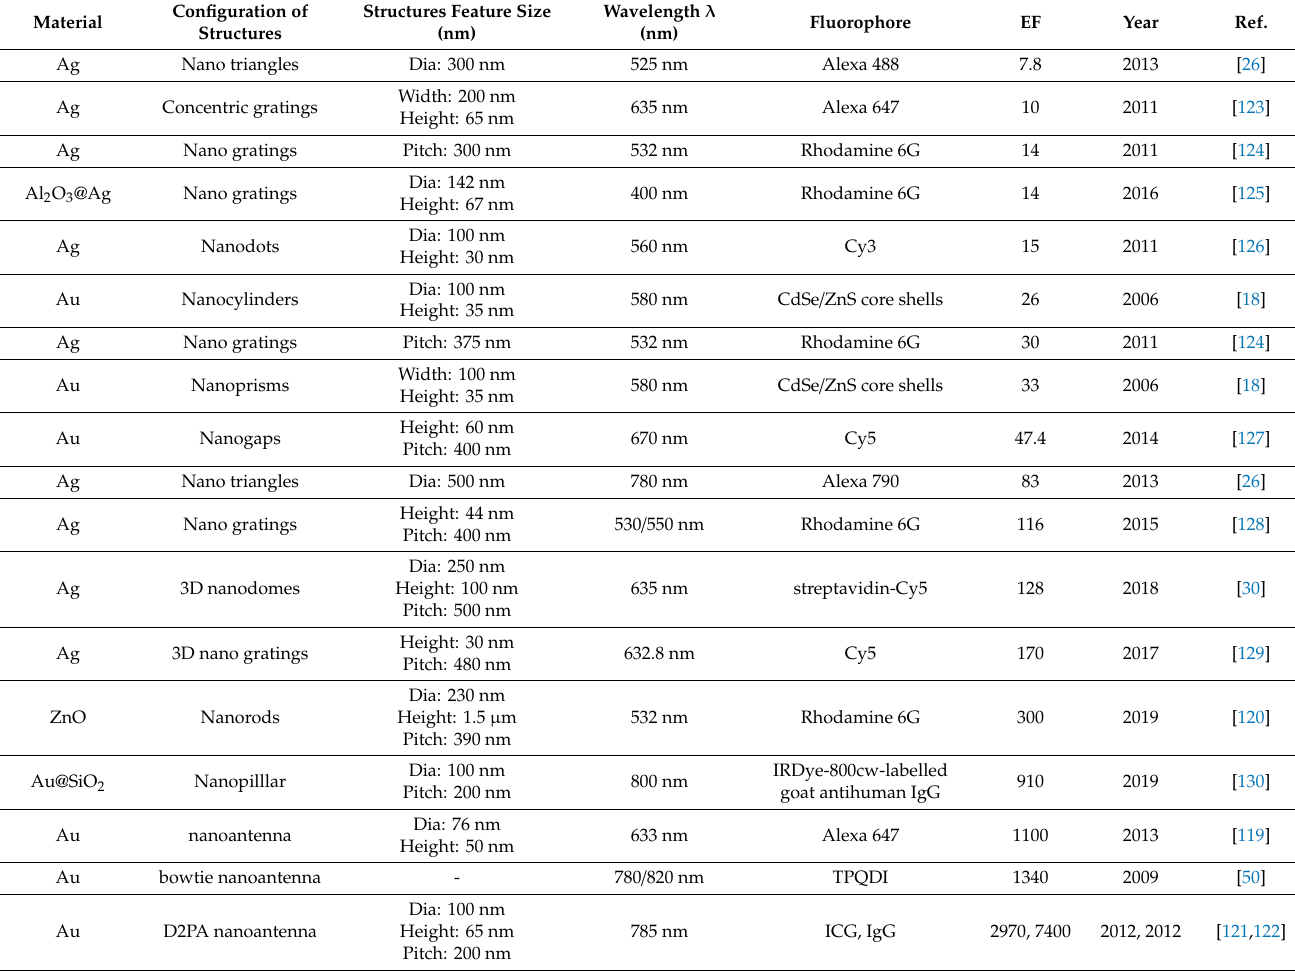
Table 4. Summary of various nanostructures fabricated via various lithography methods with di ff erent shapes and geometries, and their experimentally determined enhancement factor (EF), with feature size, excitation wavelengths, used fluorophores, and publication information such as year and reference, for further